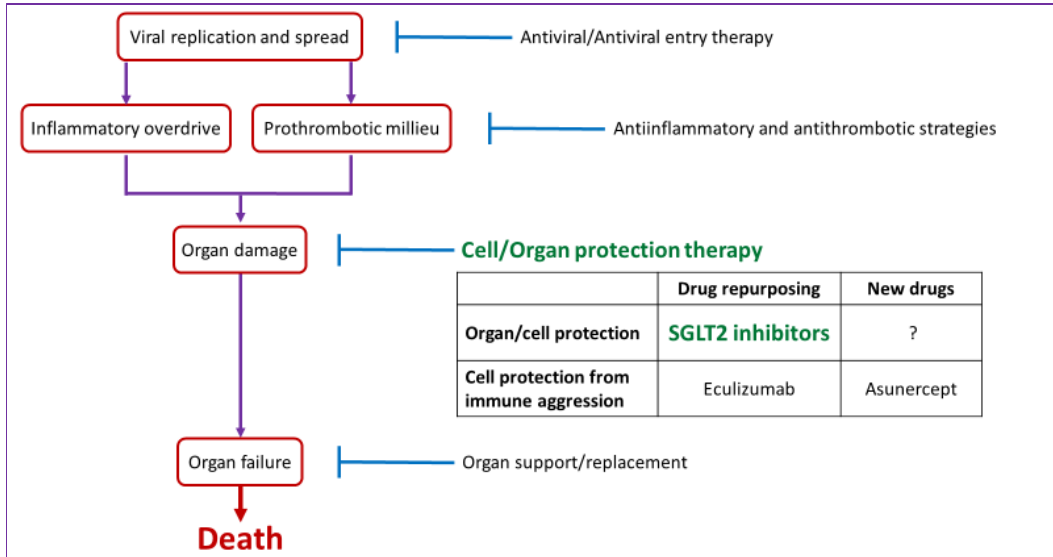
Figure 1. Pathogenic basis of current therapeutic approaches to COVID-19 and potential place of SGLT2 inhibitors.